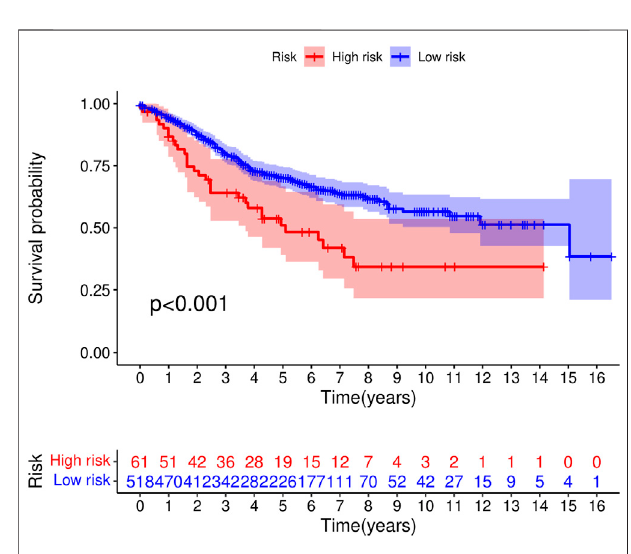
FIGURE 12 | Scatterplots of correlation analysis of riskscore and immunecells.MemoryBcellswere correlatedwith theriskscore ( p < 0.05,R > 0), indicating that its content was positively correlated with the risk of the patients.